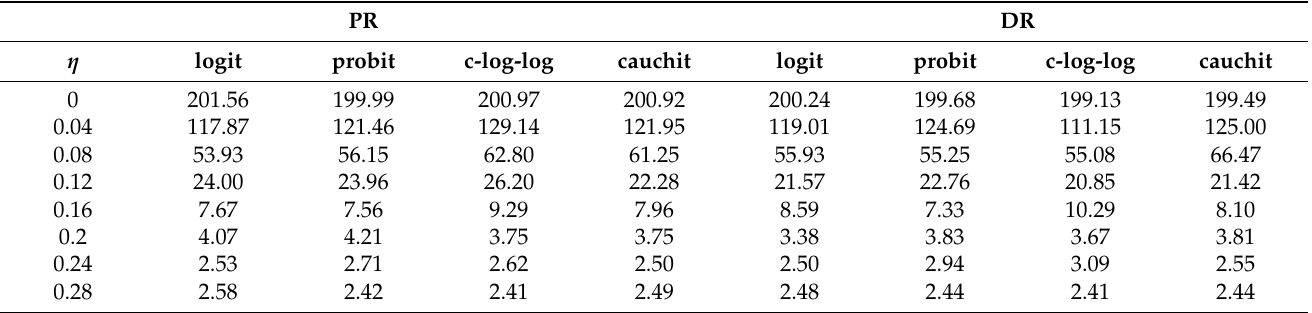
Table 2. Performance of ARL 0 = 200 with shift in β 0 under considered link functions.